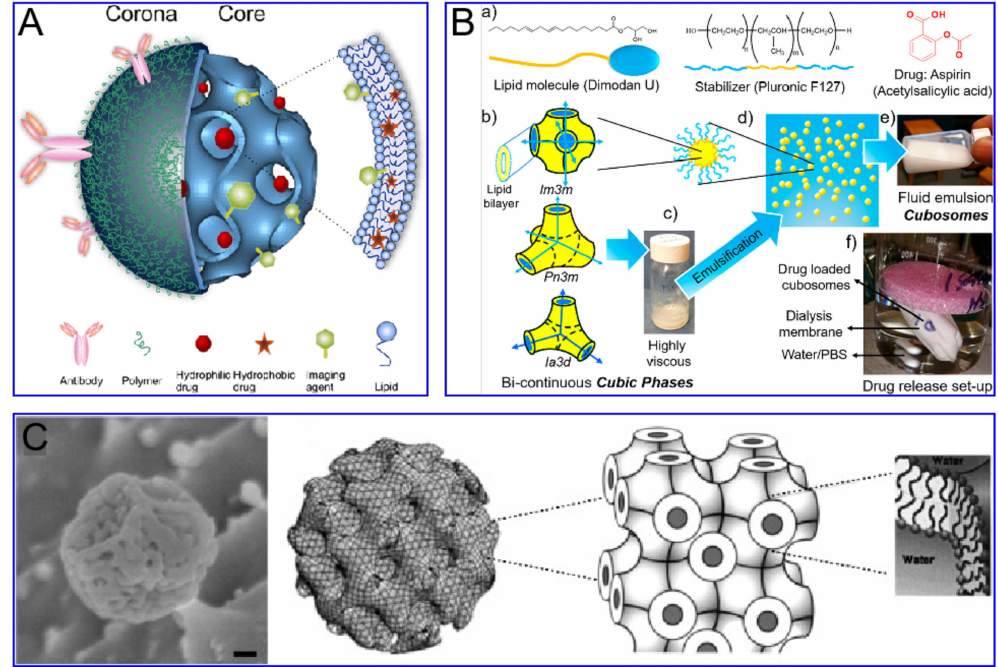
Figure 3. Cubosomes for therapeutic agent delivery; ( A ) Typical cubosome schematic. Reprinted with permission [13]. Copyright (2019) American Chemical Society. ( B ) Cubosomes were used to transport small molecule drugs to cancer tissue. Reprinted with permission [14]. Copyright (2013) Adv Drug Deliv Rev. ( C ) Cubosomes were used to delivery biological macromolecular drugs for immunotherapy. Reprinted with permission [15]. Copyright (2015) American Chemical